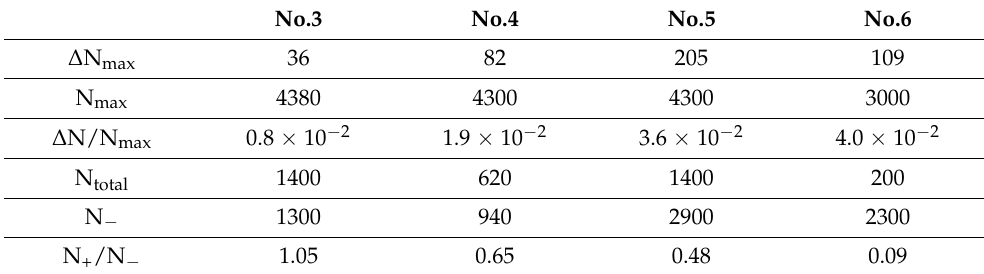
Table 4. VLPD parameters in samples with an increase in defects over a measurement period of 18